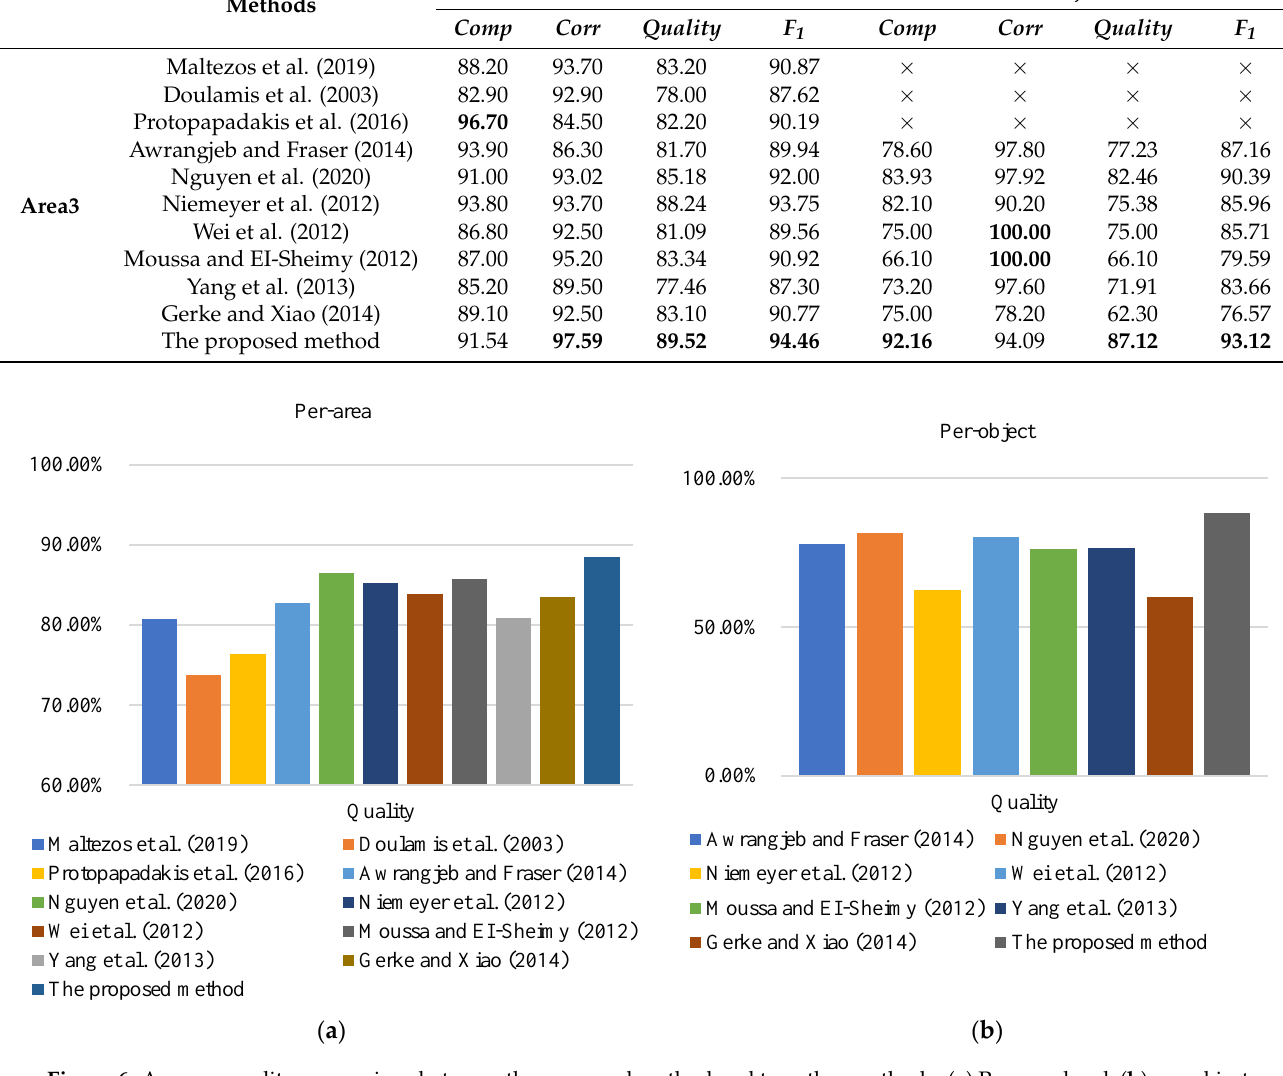
( b ) Figure 7. Average F1 score comparison between the proposed method and ten other methods. ( a ) Per-area level; ( b ) per- object level. The F1 score of the ten methods are obtained from the corresponding references. The methods proposed by Maltezos et al. (2019), Doulamis et al. (2003) and Protopapadakis et al. (2016) do not provide the quality at per-object level.